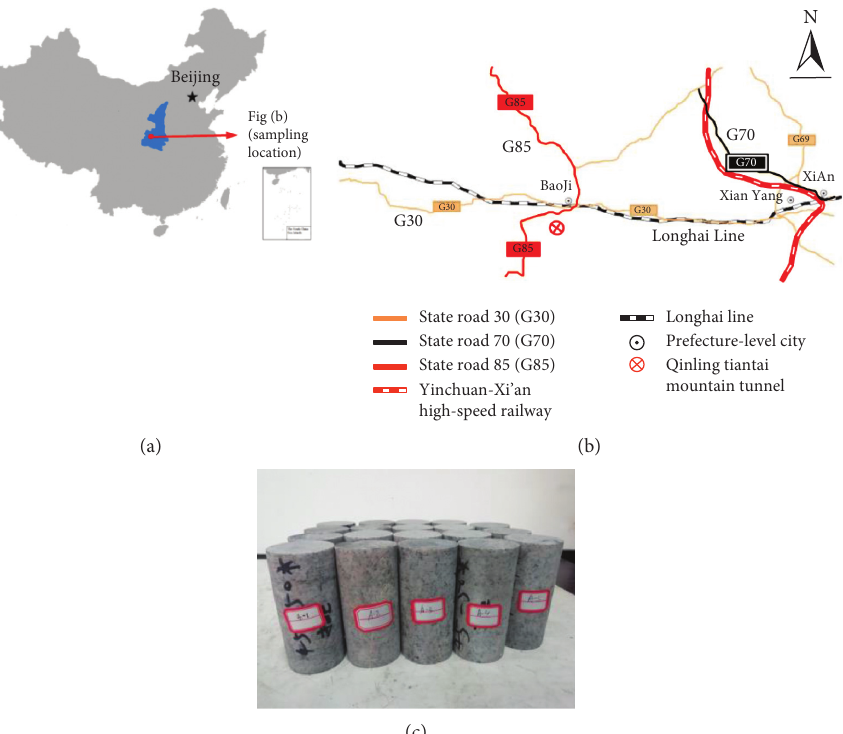
Figure 2: Granite rock samples and sampling location.